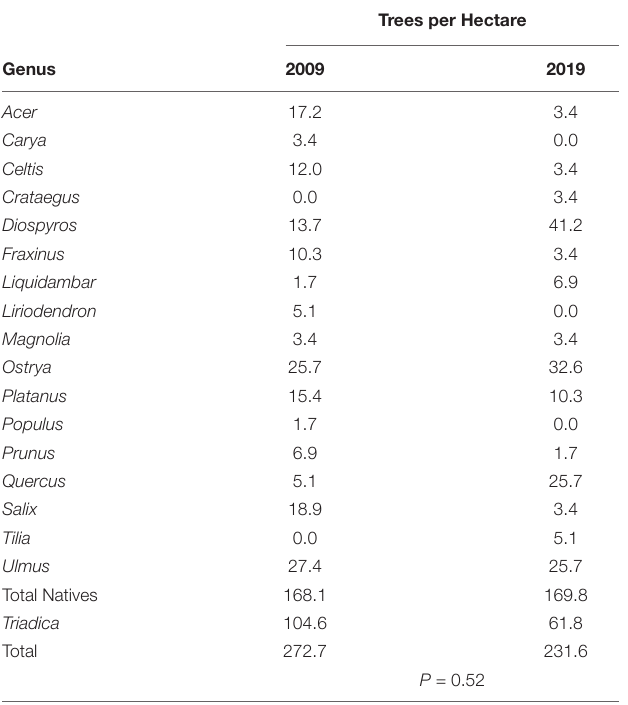
TABLE 3 | Sampling statistics for estimates of natural reproduction of total native species and total including alien invasive Triadica sebifera greater than 1-m tall after Hurricane Gustav damage and salvage logging in 2009 and 2019 ( n = 18).